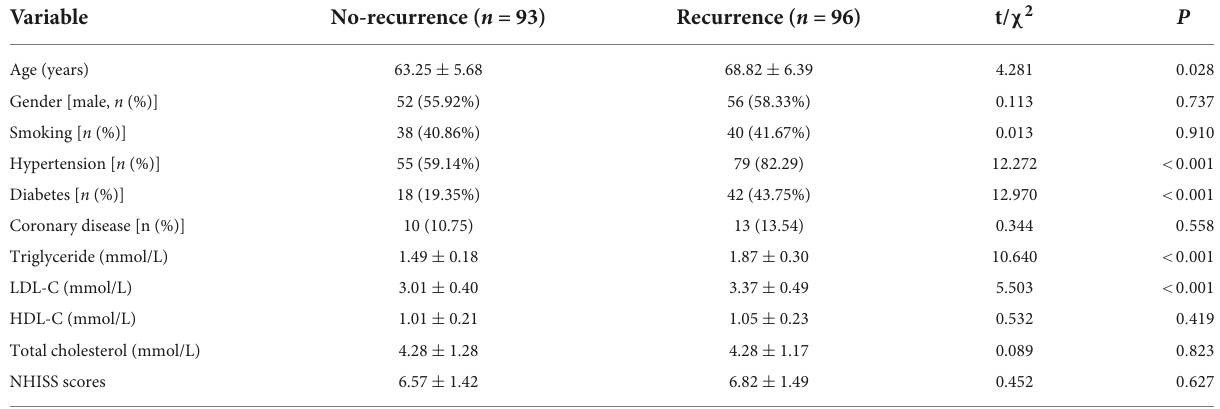
TABLE 1 Baseline data of primary cerebral infarction patients.